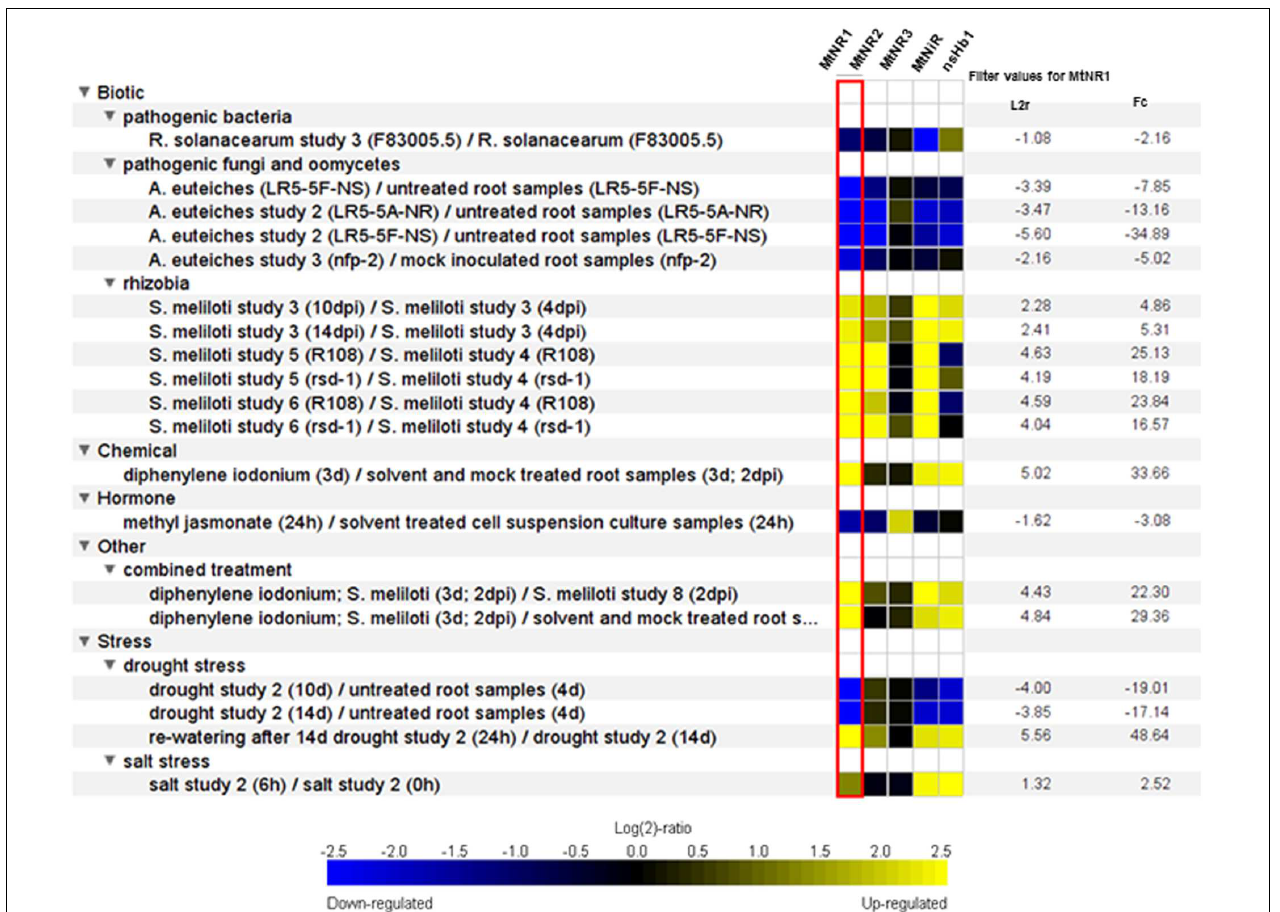
FIGURE 1 | Screenshot of the results obtained with the Genevestigator Perturbation tool for the Medicago truncatula MtNR1 (MTR_3g073170), MtNR2 (MTR_5g059820), MtNR3 (MTR_3g073150), MtNiR (MTR_4g086020), ns-Hb1 (MTR_4g068860) genes on the Affymetrix 61K Medicago GeneChip. The “Heatmap-List” view is presented here. Perturbations are ordered according to the expression log2-ratios of MtNR1 and are filtered to keep only the perturbations leading to a atleast twofold-change and a p -value of maximum 0.05. Perturbations having the highest log2 ratio are listed first. R. solanacearum , Ralstonia solanacearum ; A. euteiches , Aphanomyces euteiches ; S. meliloti , Sinorhizobium meliloti .